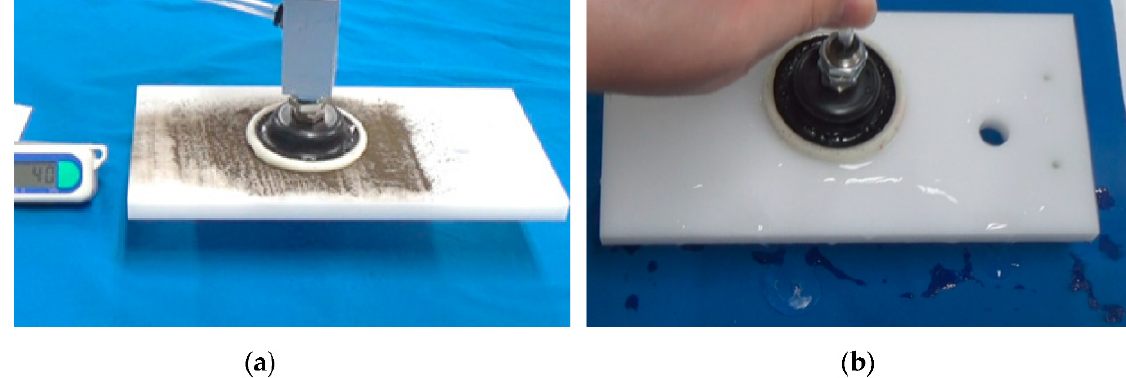
Figure 11. Experiment to confirm the possibility of adsorption of the HS Cup in harsh environments: ( a ) a plastic plate covered with dust can be adsorbed a few times; ( b ) a plastic plate covered with dust can be adsorbed a few times.